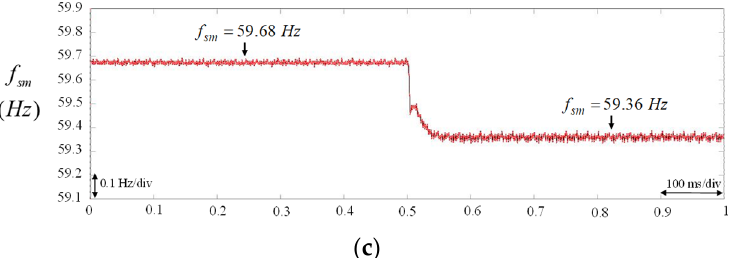
2 kgm . 2 . ( a ) Responses of real ( a ) Responses of real Figure 5. BESS using VSG control with constant virtual inertia J s = 0 kgm of BESS; ( b ) responses of line-to-line voltage v sout ab